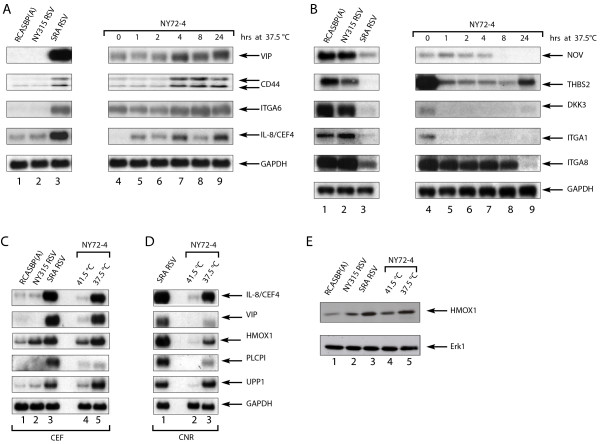
Validation of gene profiling results by northern and western blotting analyses. Steady state transcript levels for a selected set of v-Src regulated genes were determined by northern blotting analyses (A-D). CEF infected with RCASBP(A), NY315 or SR-A RSV were maintained at 41.5°C for the duration of the analysis while NY72-4 RSV infected cells were cultured at the permissive and non-permissive temperatures of 37.5°C and 41.5°C, respectively, for the indicated period of time. AB) CEF infected with NY 72-4 RSV were grown at the non-permissive temperature of 41.5°C and transferred to 37.5°C for the indicated period. C-D) CNR cells infected with NY 72-4 RSV were grown at the permissive temperature of 37.5°C and either maintained at this temperature or transferred to 41.5°C for a 24 hr period before RNA isolation. CNR cells transformed by SR-A RSV were kept at 41.5°C. RNA loading was assessed by probing for GAPDH. E) Western blotting analysis of heme oxygenase 1 (HMOX1) in CEF. Protein samples were prepared from CEF infected RCASBP(A), NY315 or SR-A RSV at 41.5°C. CEF infected with NY 72-4 RSV were either kept at the non-permissive temperature of 41.5°C or transferred to 37.5°C for 24 hrs before lysis. Erk1 was used as a control to assess protein loading.